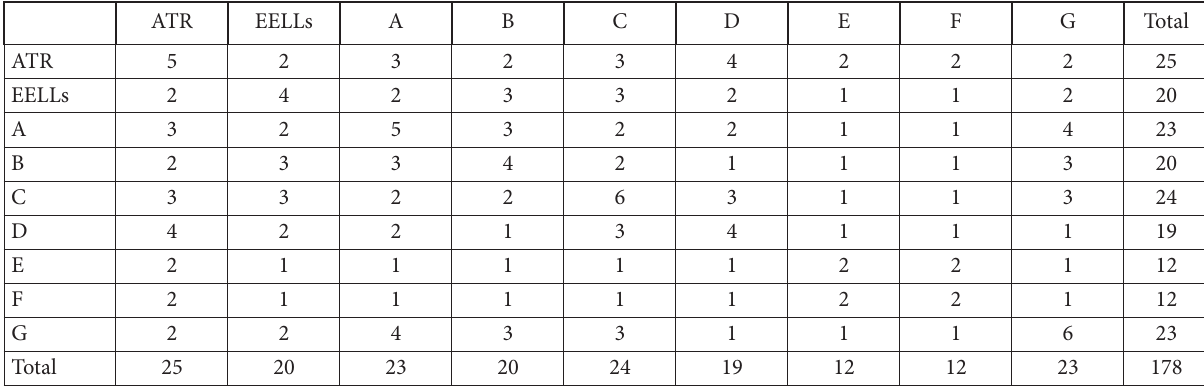
Table 2. The matrix of second-order ties